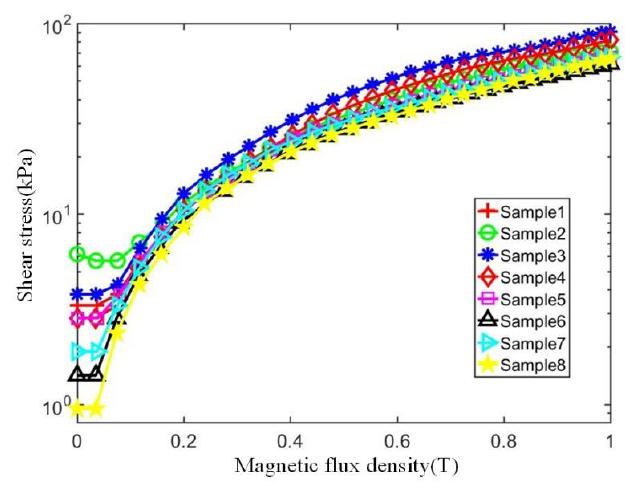
Figure 4. Relationship between shear stress and magnetic flux density at a fixed shear rate of 10 s −1 .